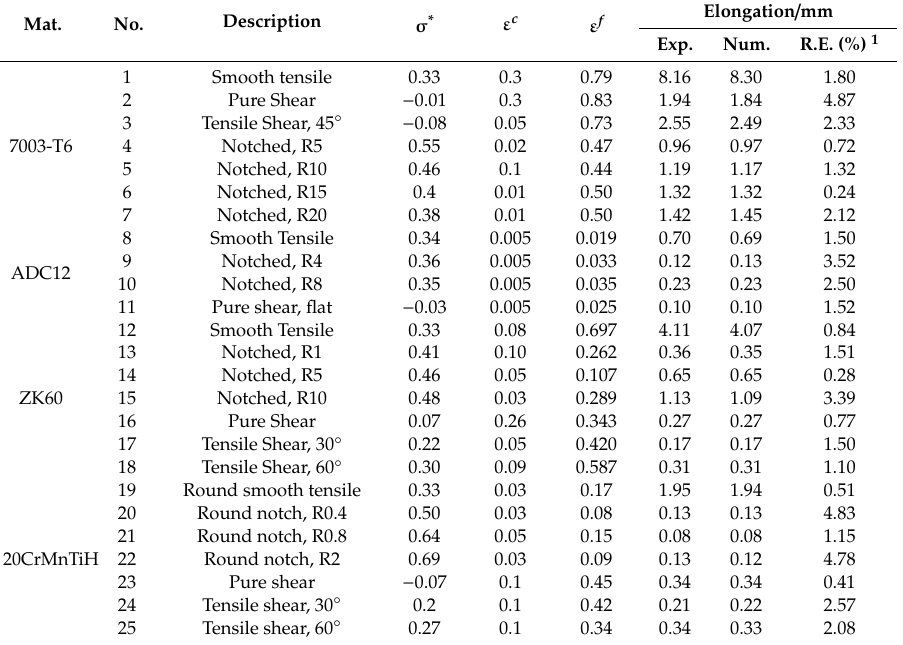
Figure 4. Engineering stress and strain curves for ( a ) 7003 aluminum alloy, ( b ) ADC12 aluminum alloy, ( c ) ZK60 magnesium alloy and ( d ) 20CrMnTiH Steel. Table 4. Summary of experimental and numerical